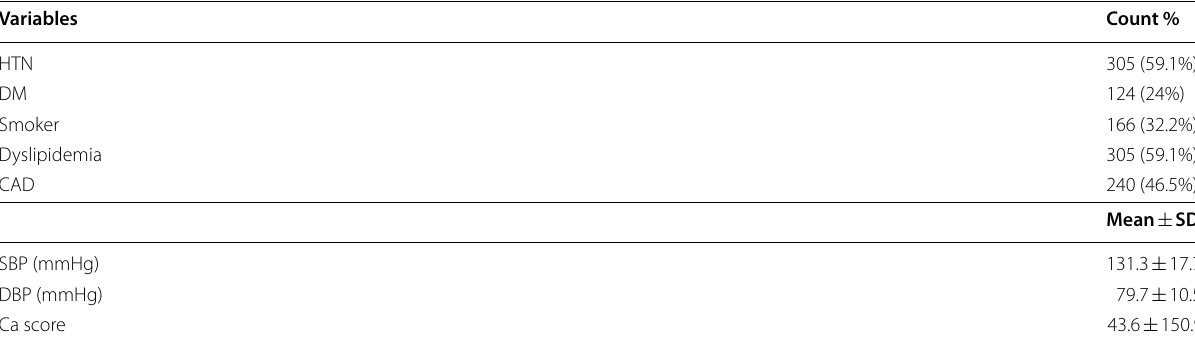
Table 3 Baseline clinical characteristics of the study